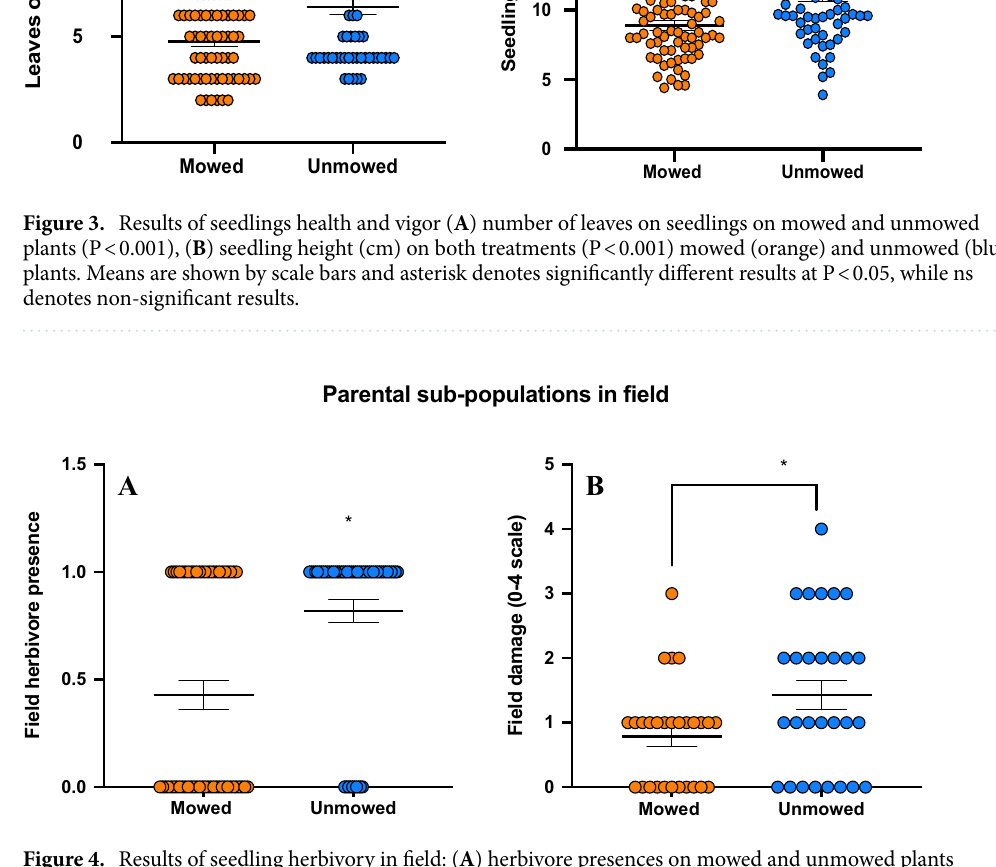
Figure 4. Results of seedling herbivory in field: ( A ) herbivore presences on mowed and unmowed plants (P < 0.001; binary logistic regression; Wald’s test), ( B ) damage by insects on both treatments (scale 0–4) (P = 0.037; ordinal logistic regression; Wald’s test) mowed (orange bar) and unmowed (blue bar) plants. Means are shown by scale bars and asterisk denotes significantly different results at p <